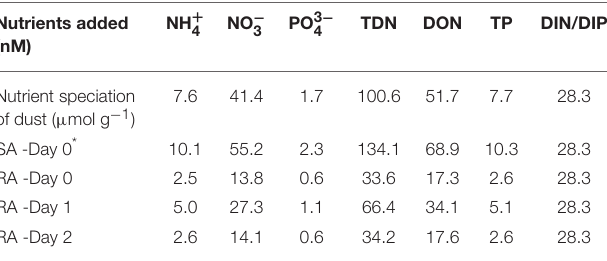
TABLE 2 | Concentrations and speciation of Phosphorus and Nitrogen added with dust. Nutrients added NH + 4 NO − 3 PO 3 − 4 (nM)